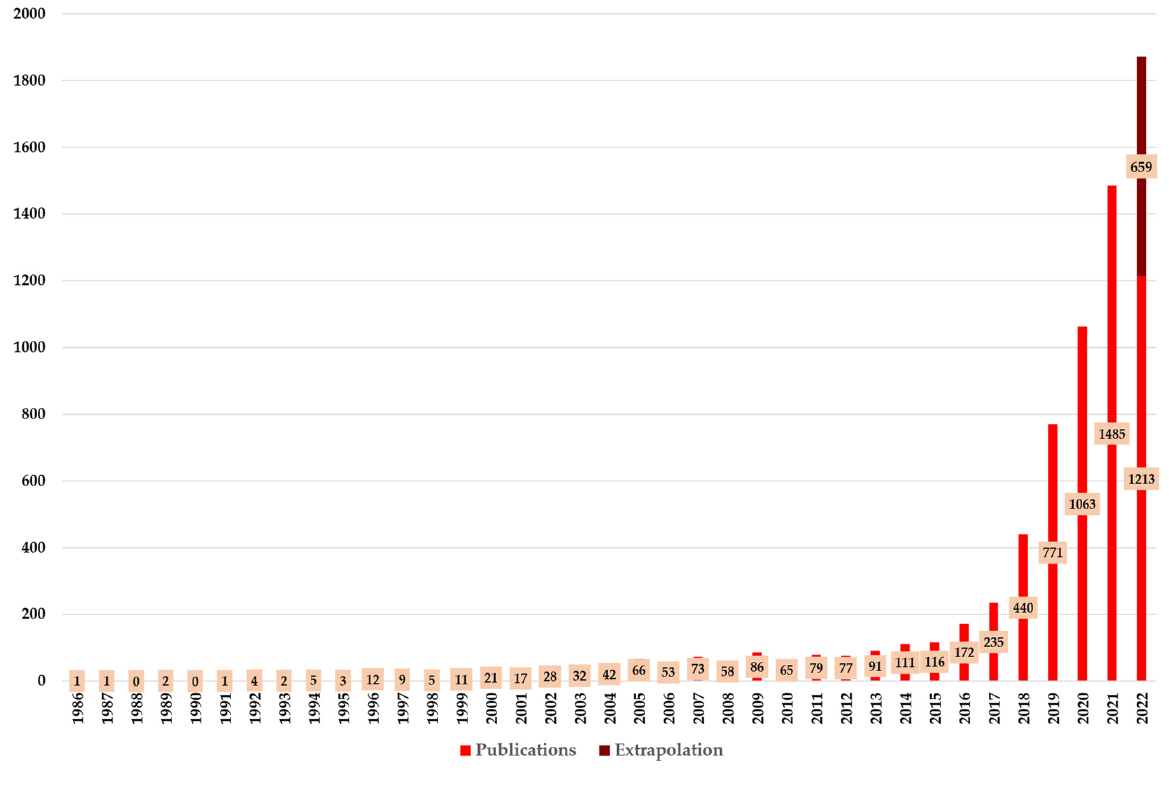
Figure 2. Overview of the annual production.